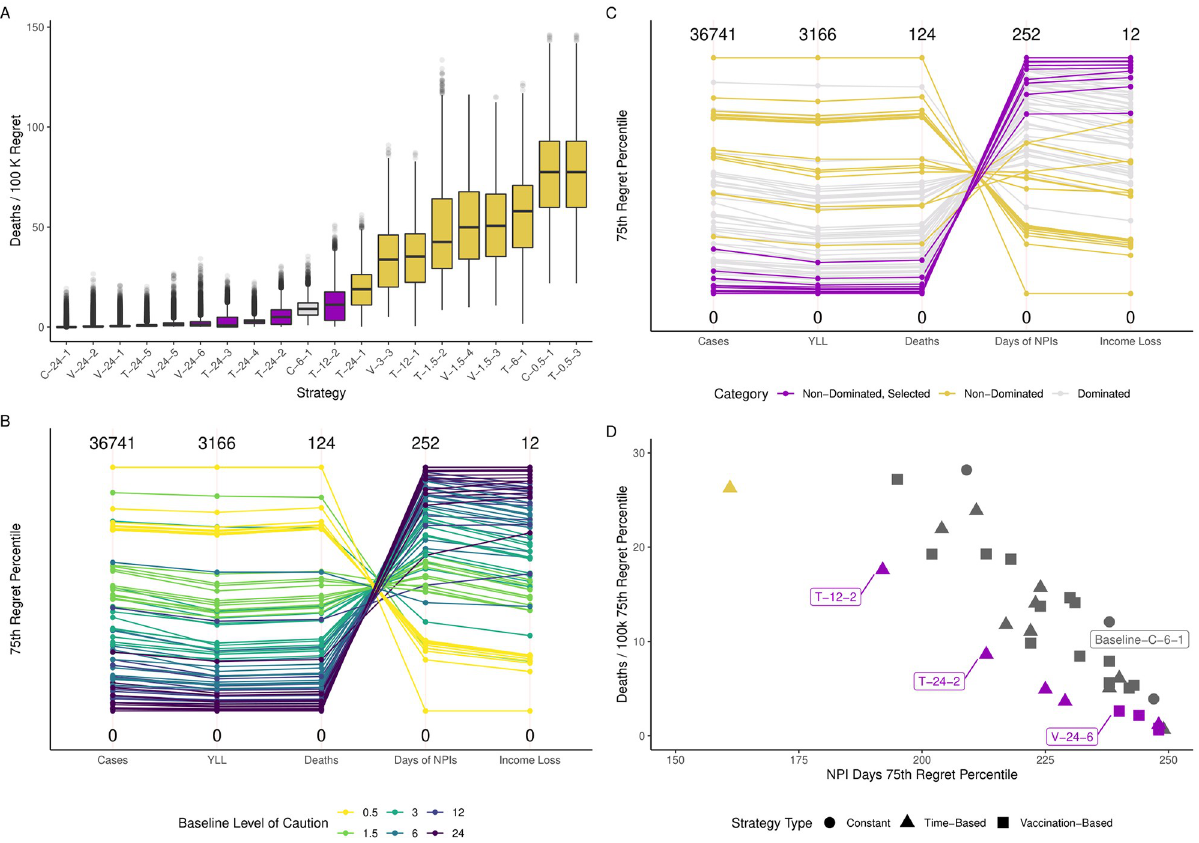
Fig 2. Robustness trade-offs emerging from 78 alternative reopening strategies. Panel A shows the distribution of a Regret metric for four outcomes of interest. Each line in Panel B and C represents a single strategy. Vertical axes represent the 75 th Regret percentile for each metric. All Health outcomes are normalized per 100 thousand people. Strategies are coded as follows. The first letter indicates whether the NPI strategy uses a Time-based level of caution (T), a Vaccination-Based level of caution (V), or a Constant level of caution (C). The subsequent number describes the baseline level of caution x and a third number is a sequential number that creates a unique code for each strategy. Table 1 contains a description of all strategies. b